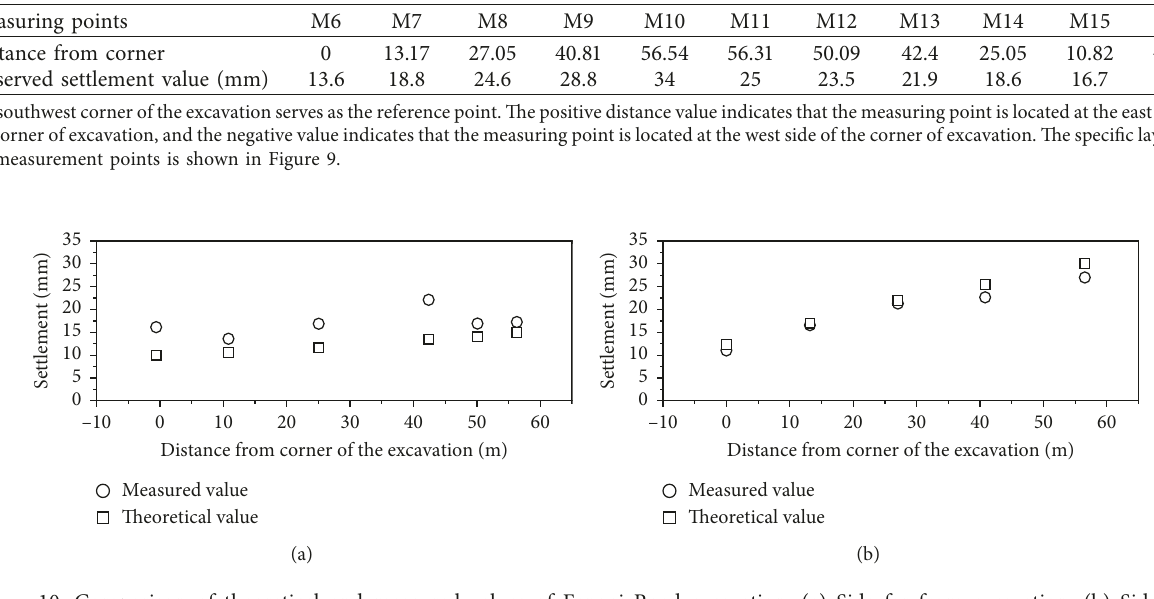
Table 3: Observed soil surface settlements at measuring points of Fengqi Road excavation.